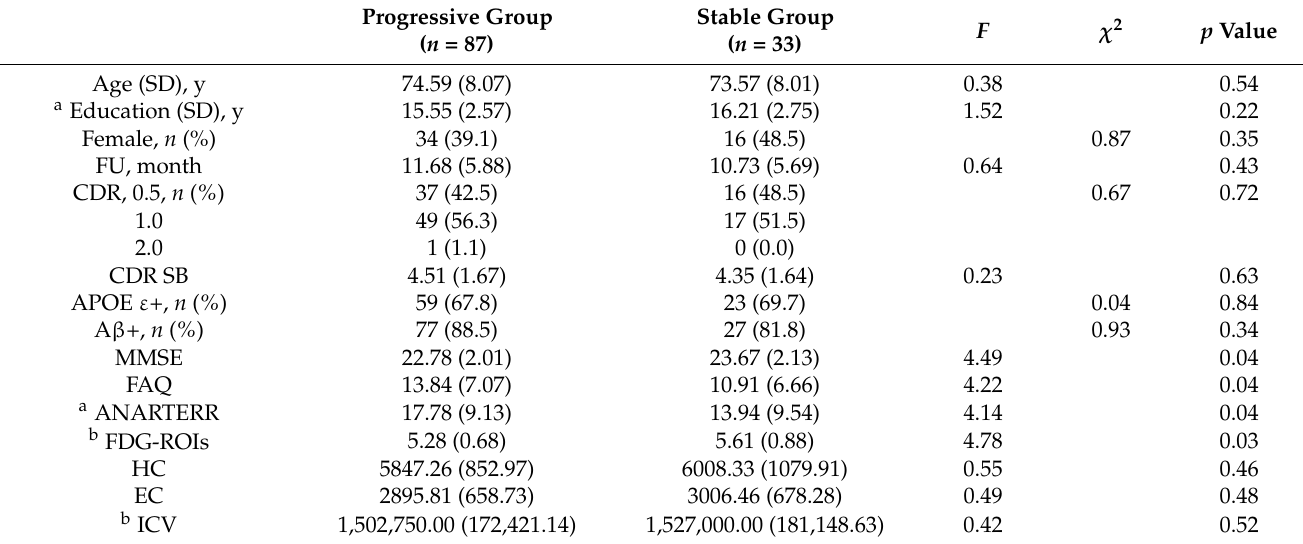
Table 1. Demographic and clinical characteristics of the participants at